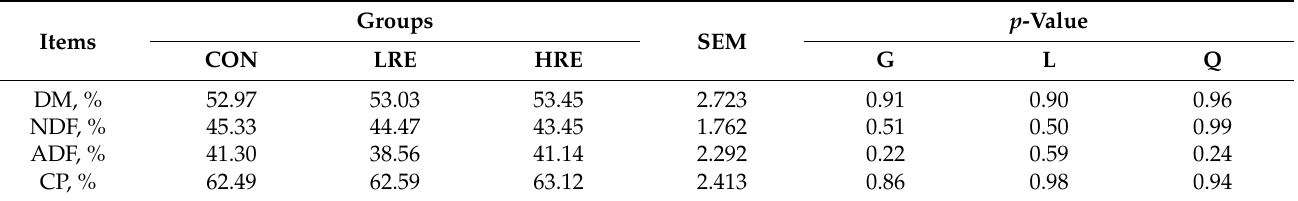
Table 3. Effects of different doses of rosemary extract on nutrient degradability measured in in vitro